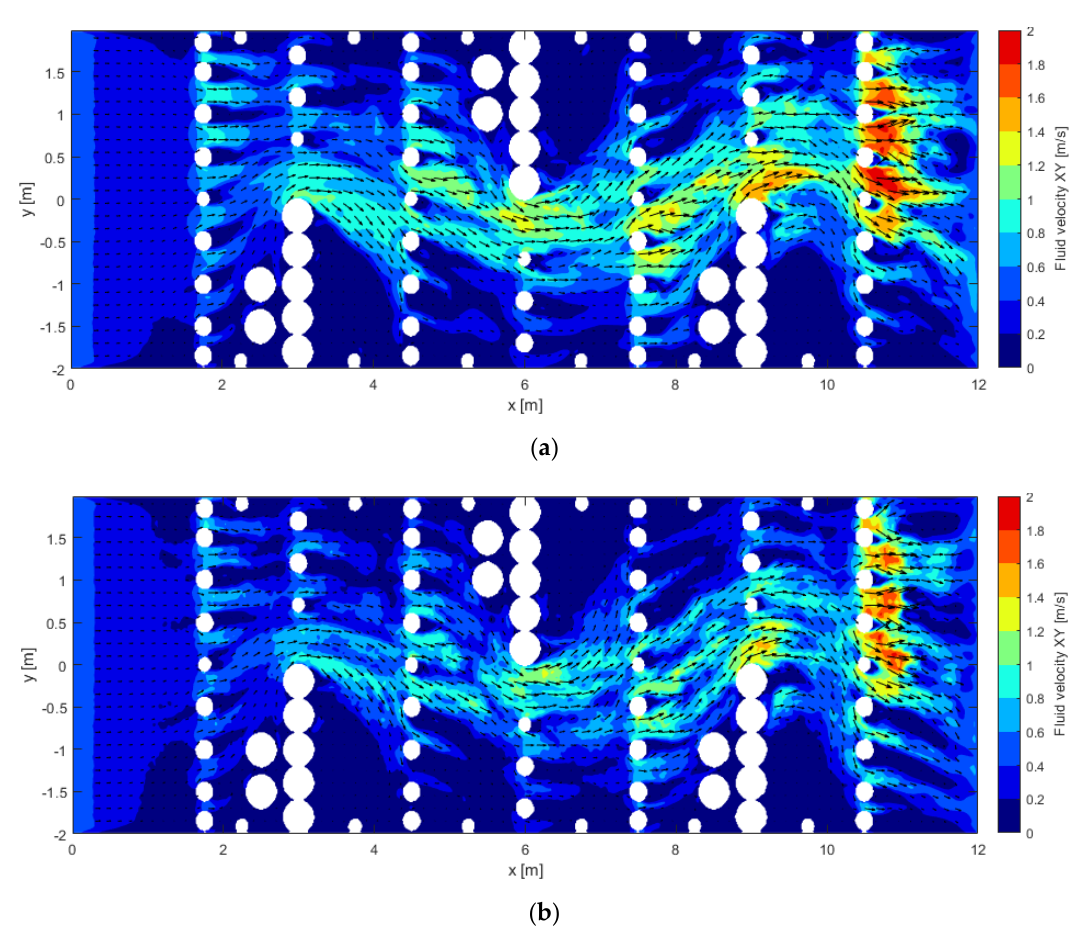
Figure 14. Velocities close to the bottom at z = 0.05 m plane for the Q 2 case ( a ) with smooth bed and ( b ) bed roughness.